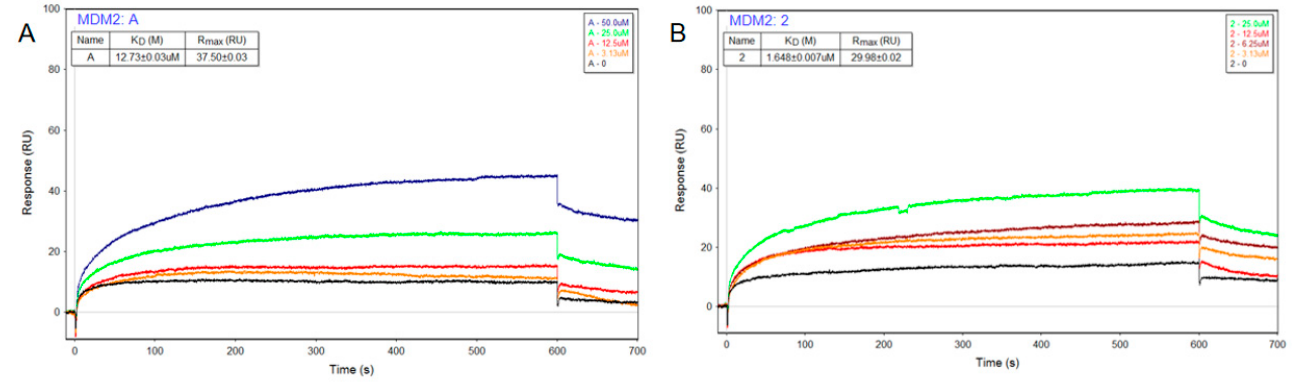
Figure 7. The binding curve of MDM2 with GAA ( A ) and A2 ( B ).